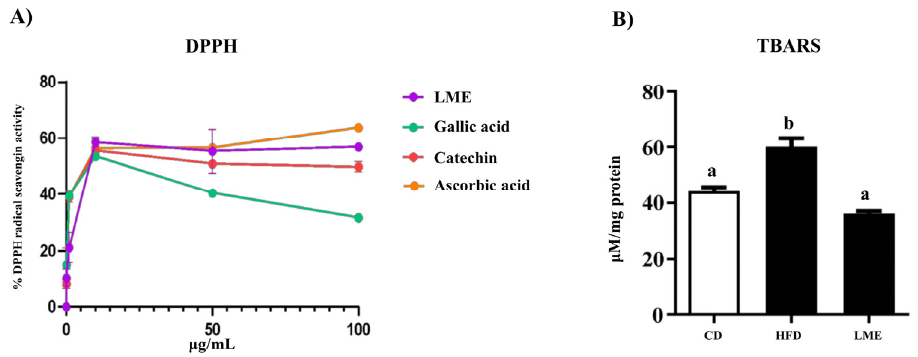
Figure 2. ( A ) DPPH activity scavenging of LME, gallic acid, epicatechin, and ascorbic acid; ( B ) TBARS production in liver lysates. Data are expressed as means ± SEM ( n = 4). Groups with different letters statistically differ ( p < 0.05).